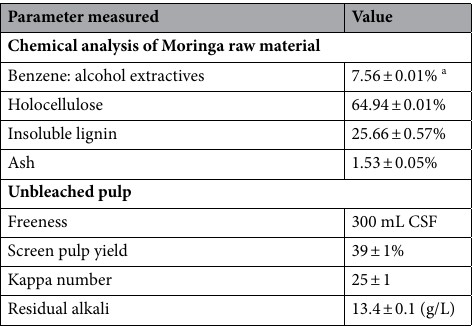
Table 1. Chemical composition of M. oleifera SRRP and unbleached pulp. a Values are presented as mean± SD. SD Standard